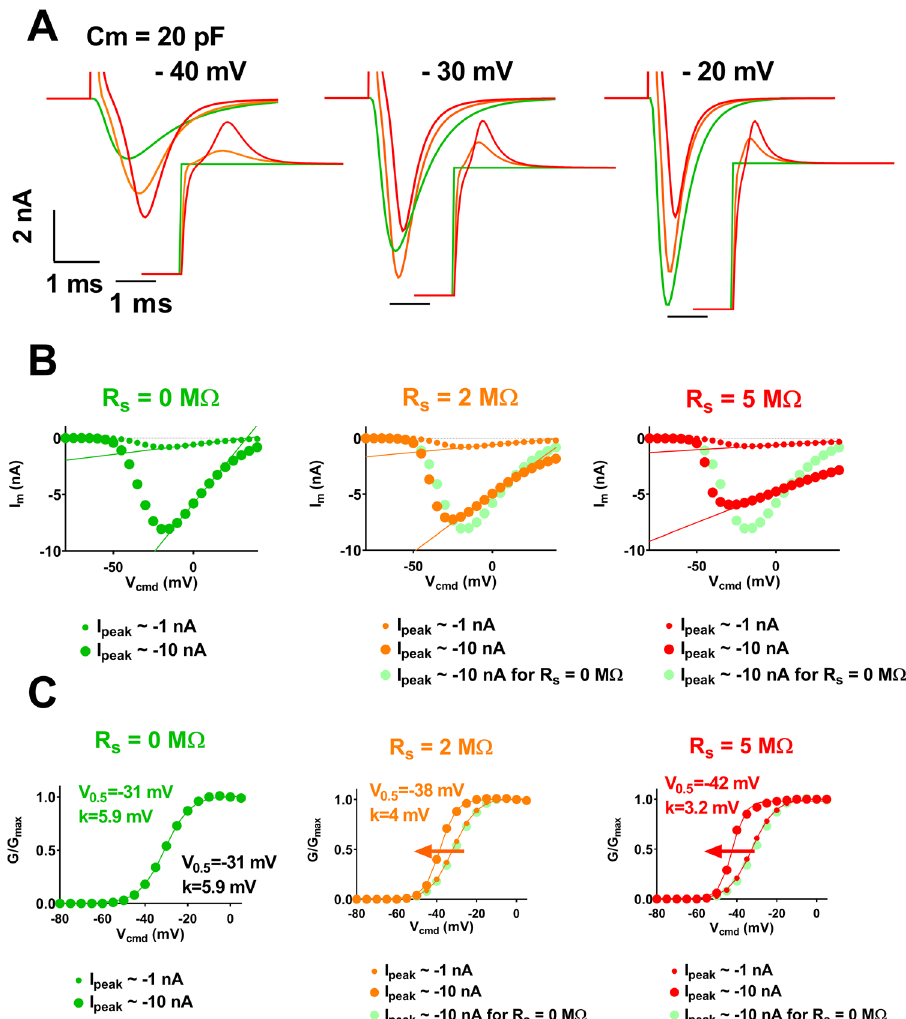
Figure 3. Kinetic model of cardiac I Na current (Na v 1.5)—computed effects of increasing series resistance and current amplitude range on apparent current parameters. ( A) Computed time course of I Na current at the indicated command potential, for various values of R S , as indicated by colors. ( B) Peak current/voltage (I/V) relationships in the three conditions. Optimal I/V curve is repeated (light green), allowing easy comparison. Straight lines are fits of the I/V curves when voltage-dependent activation is achieved. The slope of the linear function corresponds to the maximal conductance. ( C ) Activation curves (G/G max vs V cmd ) in various conditions as indicated by color and symbol size. Theoretical half-activation potential (V 0.5 ) and slope (k) values in black. V 0.5 and k for R S of 0, 2 and 5 MΩ and current range of 10 nA are indicated in